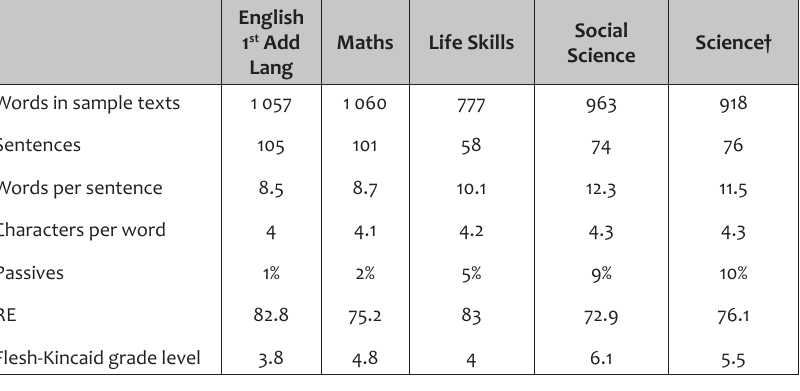
Table 2: Flesch RE in Grade 4 textbooks